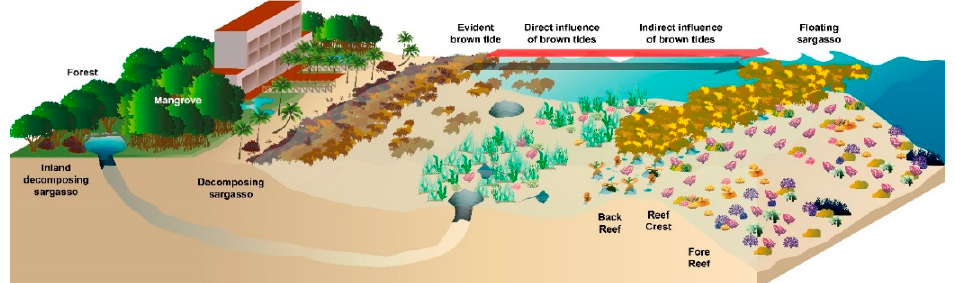
Figure 1. Schematic representation of the Mexican Caribbean coast profile and the impacts of the sargasso influx. Coastal ecosystems include: coral reef (back, crest and fore zones); seagrass meadows, algae and isolated benthic fauna (reef lagoon); beach; mangrove; forest; and underground rivers. When floating sargasso reaches the beach, if left on site, it decomposes after a couple of days, generating leachates and organic matter that reach the sea by wave action, creating brown tides that can a ff ect the flora and fauna close to shore, directly, and the coral reef, indirectly. Inadequate disposal of sargasso in the mangroves and forests may contaminate underground rivers that eventually reach the